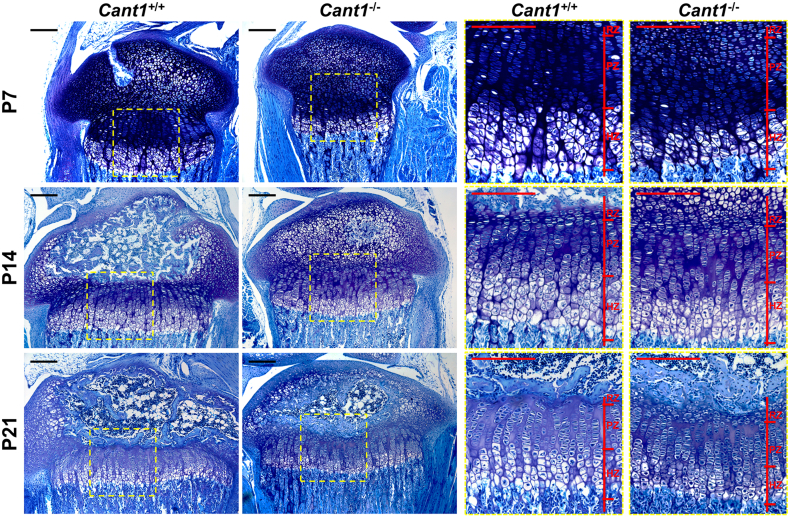
A delay in the formation of secondary ossification centre is observed in Cant1−/− mice. Proximal tibia sections of P7, P14 and P21 Cant1−/− and Cant1+/+ mice were stained with toluidine blue. Areas enclosed in the yellow dashed boxes are shown at higher magnification in the right panel. RZ = resting zone; PZ = proliferative zone; HZ = hypertrophic zone; scale bar = 200 μm.